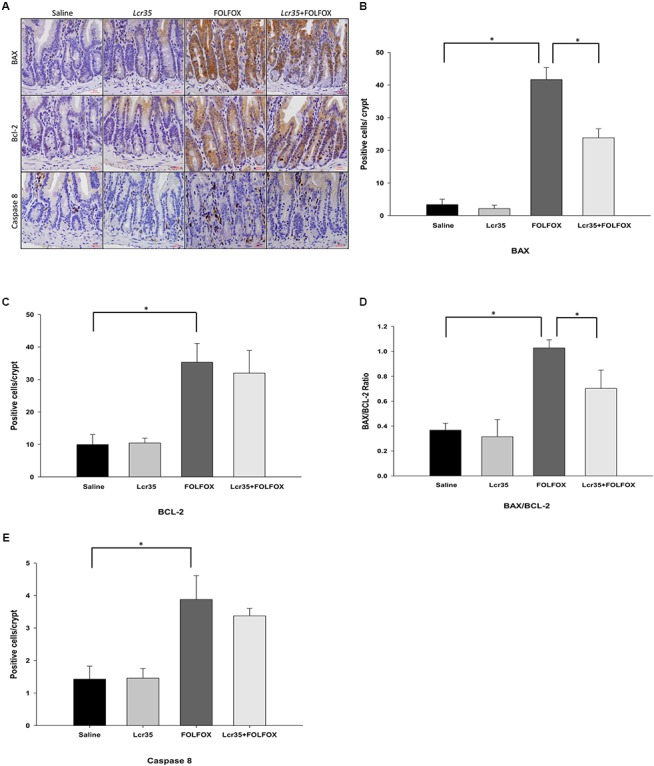
Effect of Lcr35 on BAX, BCL-2, and caspase 8 expression in FOLFOX-induced intestinal damage in subcutaneously injected colorectal carcinoma mice. Immunohistochemical staining of jejunum sections and quantification of the staining intensity in the crypts of the intestine were conducted to determine Lcr35 effects on (A,B) BAX, (A,C) BCL-2 activity (brown), (D) BAX/BCL-2 ratio, and (A,E) caspase 8 (brown) using antibodies. Scale bar = 100 μm. The mice received saline or Lcr35 (1 × 107 CFU/daily) daily during the experiment. Results are representative of four individual experiments and are presented as the mean ± SEM. ∗p < 0.05.